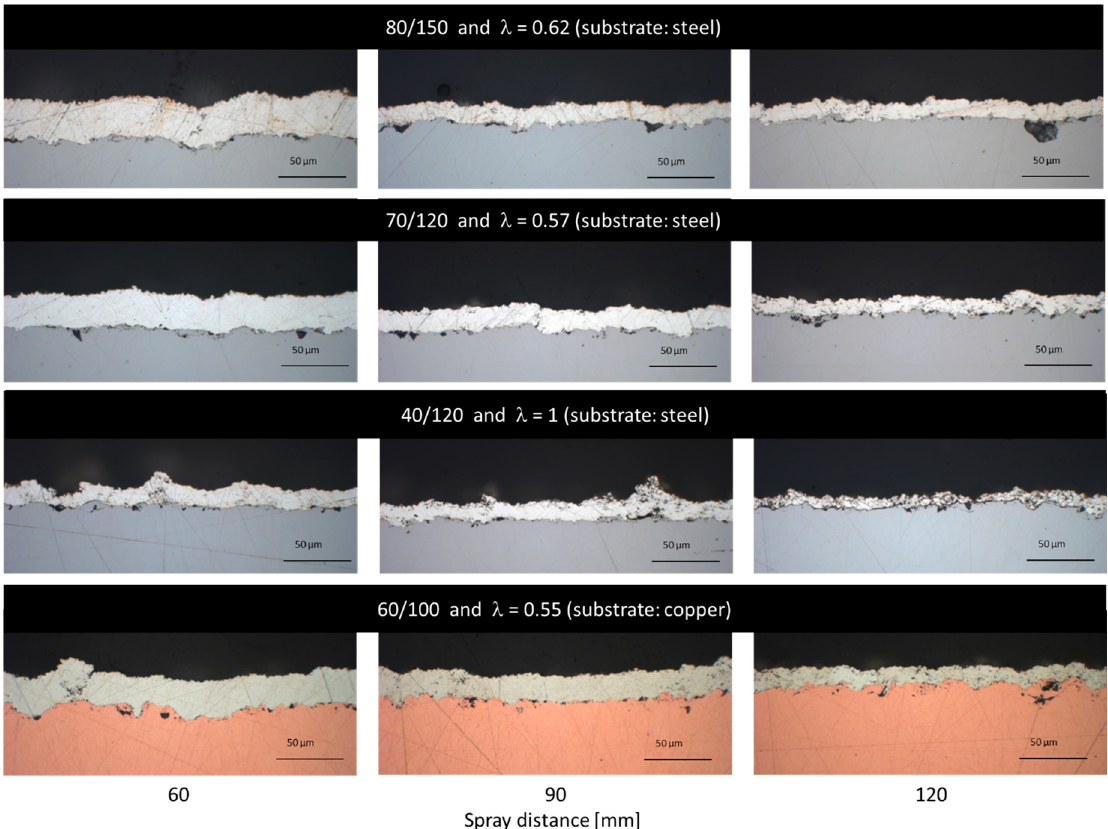
Figure 16. Optical microscope cross-section images of the Ag coatings on mild steel and Cu substrate from samples in Figure 15 chosen for 60, 90, and 120 mm spray distances. Please note that in respect of gas ratios and substrate type, images are organized in the same systematic as in Figure 15.